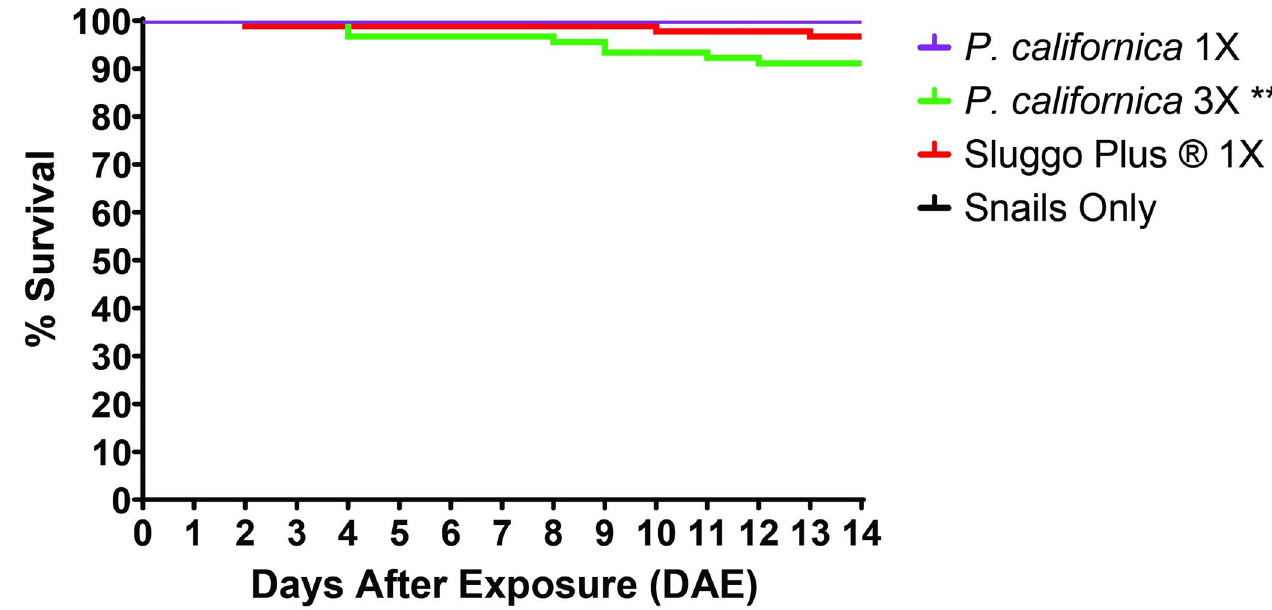
Fig 5. Kaplan Meier graph showing the percent survival of adult Theba pisana over 14 days after exposure to the Nemaslug 1 -recommended dose (30 IJs/cm 2 ) and three times the recommended dose (90 IJs/cm 2 ) of Phasmarhabditis californica (ITD726) and Sluggo Plus 1 . �� indicates a p value less than 0.01 compared to the untreated (snails only) control. Statistical analyses were performed by doing Mantel-Cox log rank analyses comparing each treatment to each other.